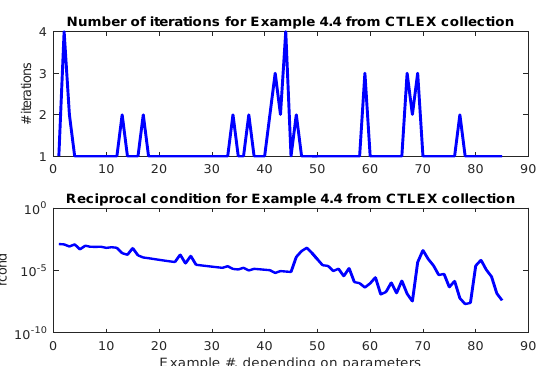
Figure 8. Number of iterations for ArLyap solver and reciprocal condition numbers for CTLEX 4.4 series of examples.